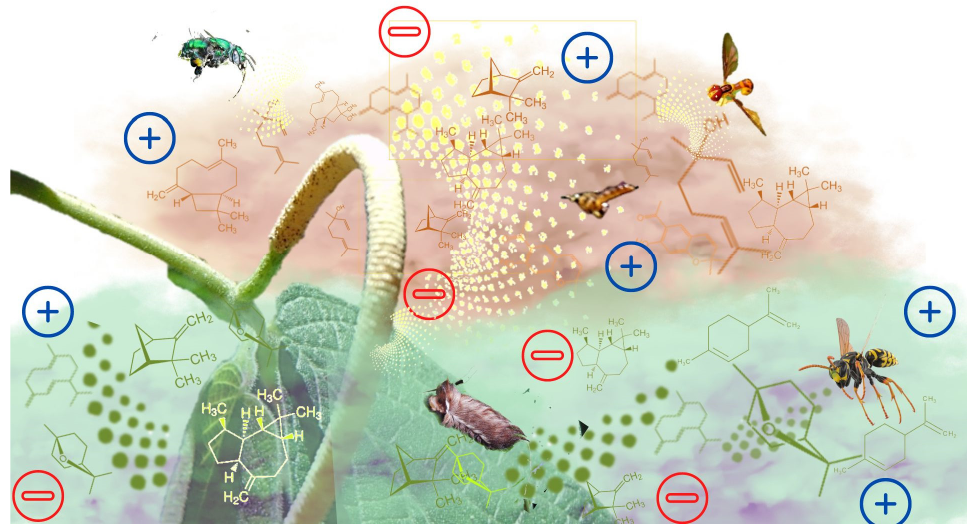
Figure 5. Illustration of possible harmonic and disharmonic interactions provided by the attraction and repulsion of volatile constituents contained in essential oils: an illustration of the Volatile Fog . These compounds interact in a blend or volatile mixture, a phenomenon that was already described.